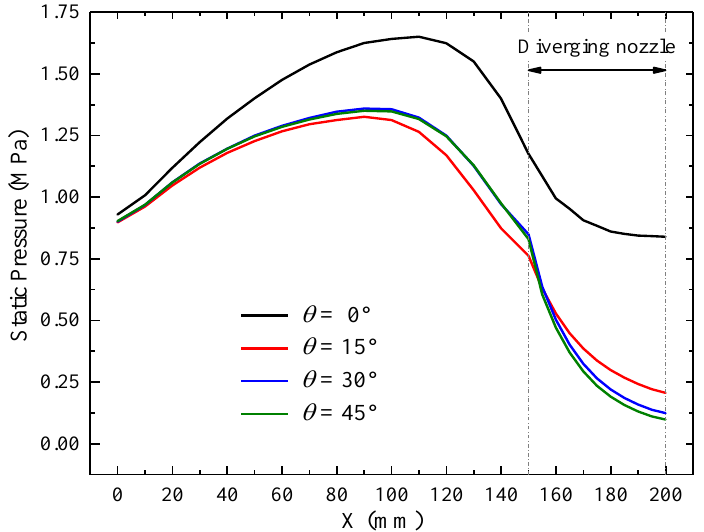
Figure 12. The averaged total pressure in di ff erent axial cross-sections of the RDC at t = 3980 µ